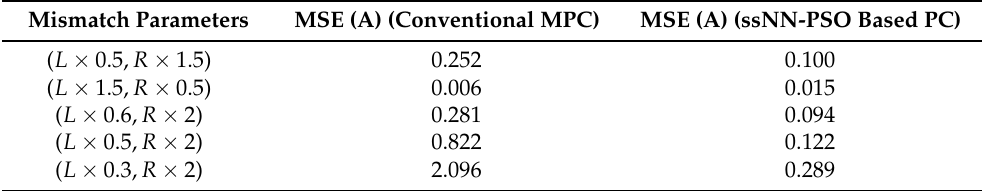
Table 2. Comparison parameter changes between model-free and model-based predictive control. Mismatch